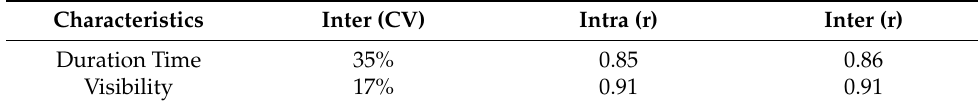
Table 4. Observer variability of duration and visibility.